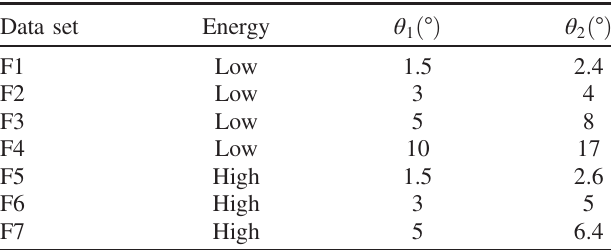
TABLE V. Table of energy scan data sets, for aluminum sample #2. The out-of-plane angle is fixed at ϕ ¼ 0 .